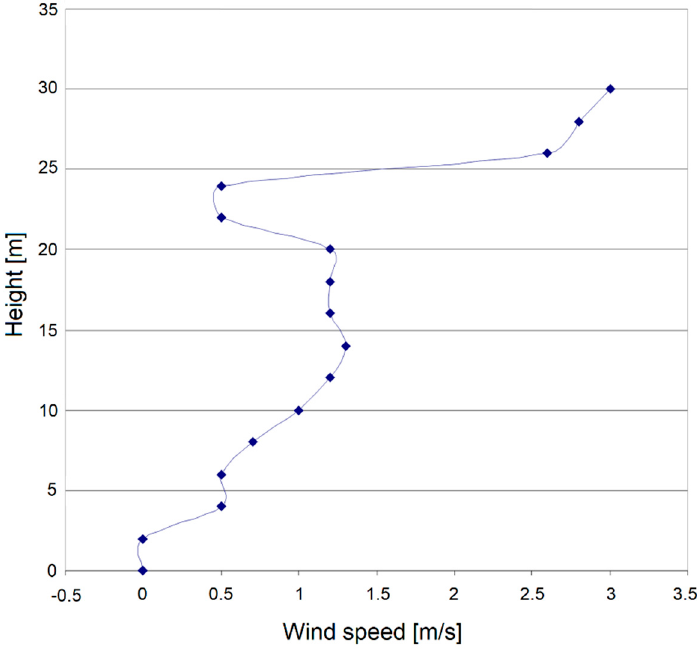
Figure 10. Vertical wind shear in a tall building (adapted from [35]).